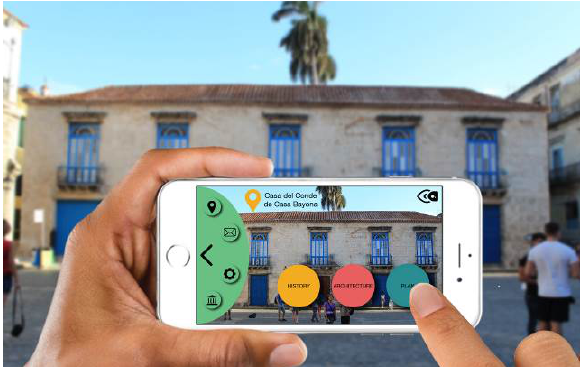
Figure 19. Example of an application of aumented reality (Plaza de la